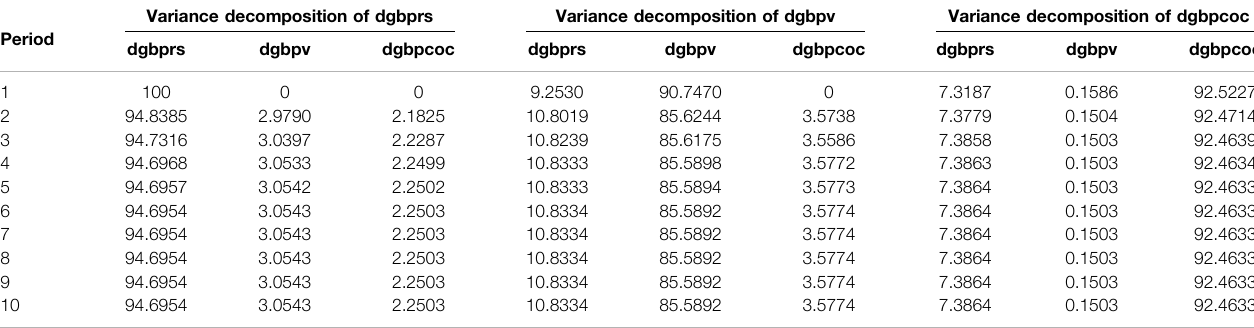
TABLE 9 | Variance decomposition – US dollar/Euro.